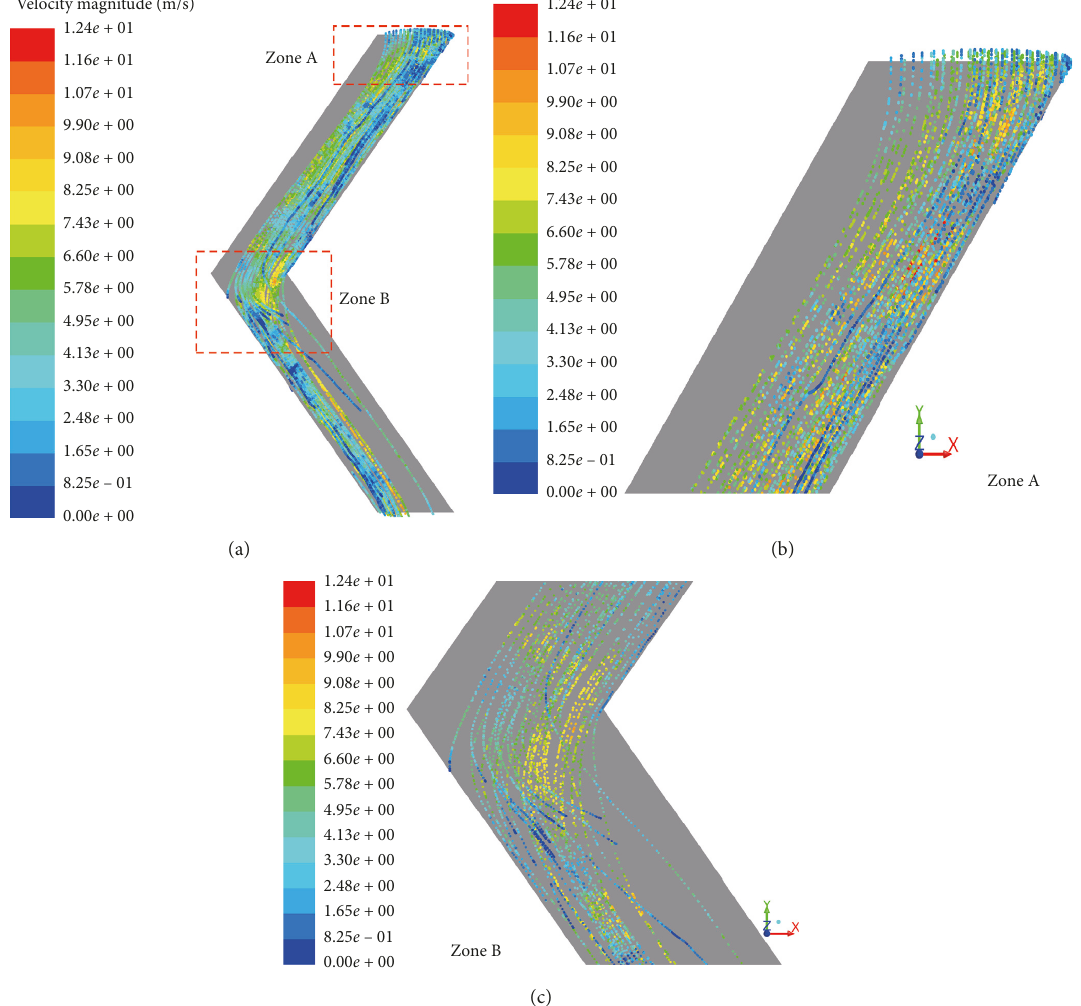
Figure 5: (a) Particle trajectories of the impactor; (b) partially enlarged view of the selected zone A; (c) partially enlarged view of the selected zone